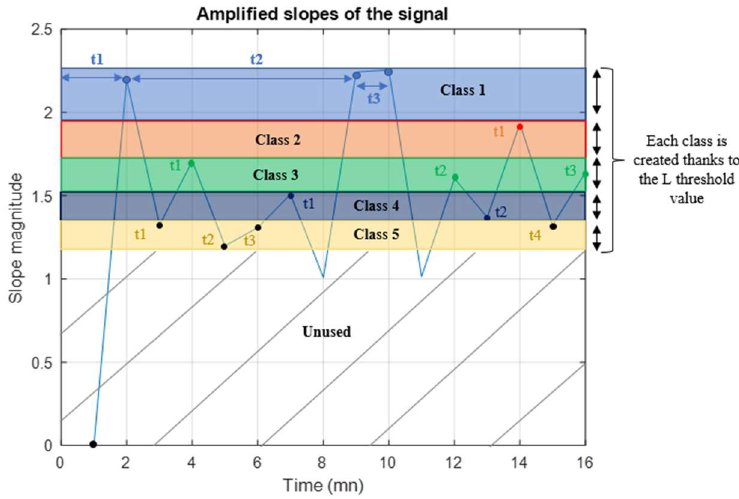
Figure 5. Class separation of the signal E as shown in Algorithms 1.